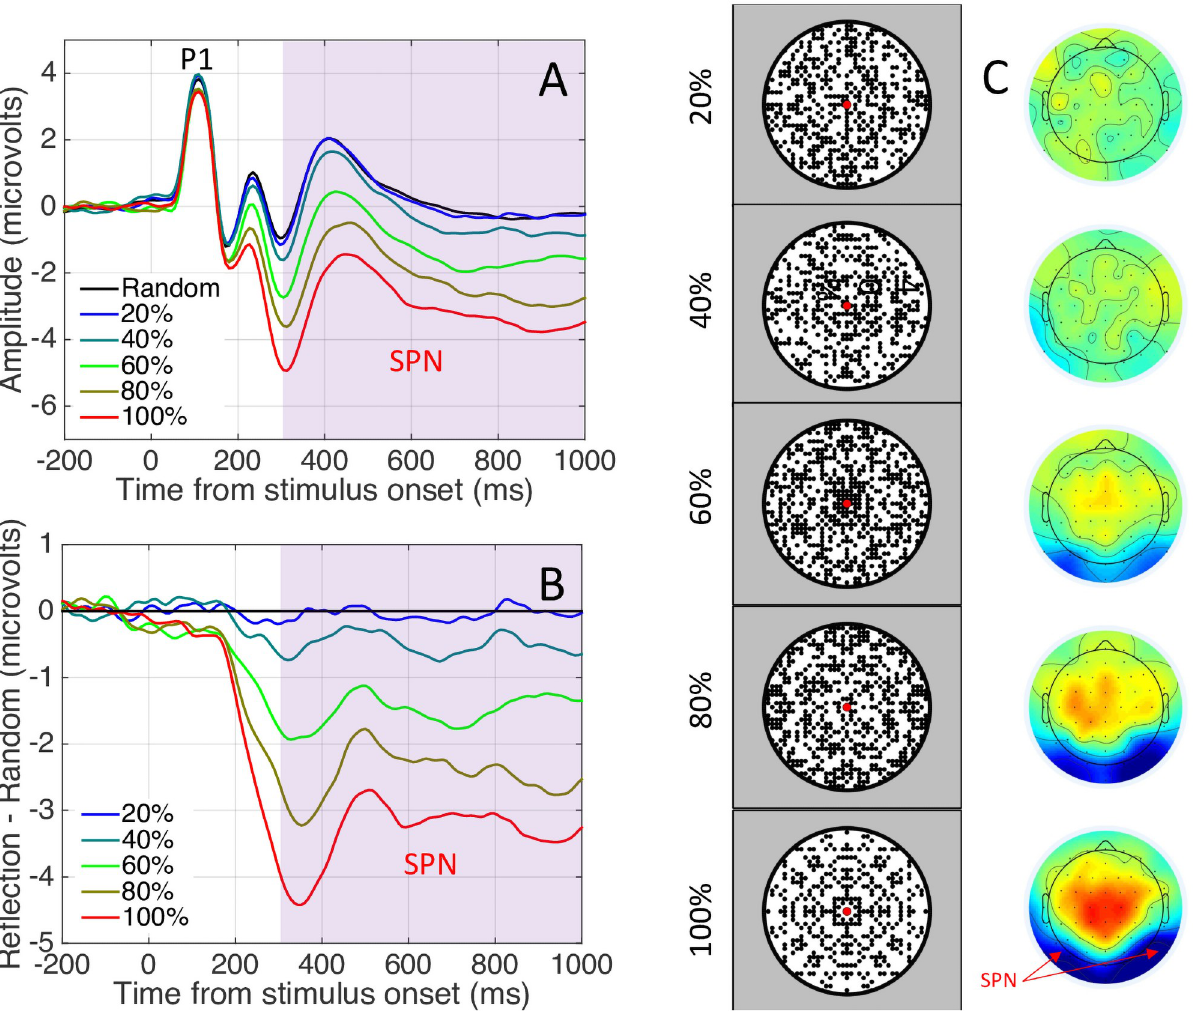
Fig 1. Example Sustained Posterior Negativity from Palumbo et al. [6]. A) Grand average ERP waves from posterior electrodes. P1 and the SPN intervals are labelled. B) SPN as a difference wave (reflection–random). Larger SPNs are ones where this difference wave falls a long way below zero. Here SPN amplitude scaled with the proportion of symmetry in the image. C) Example stimuli with 20 to 100% symmetry and corresponding topographic difference maps. Here the SPN appears as increasing blue at posterior electrodes. In the current series of experiments, we investigated how the SPN changes with repeated